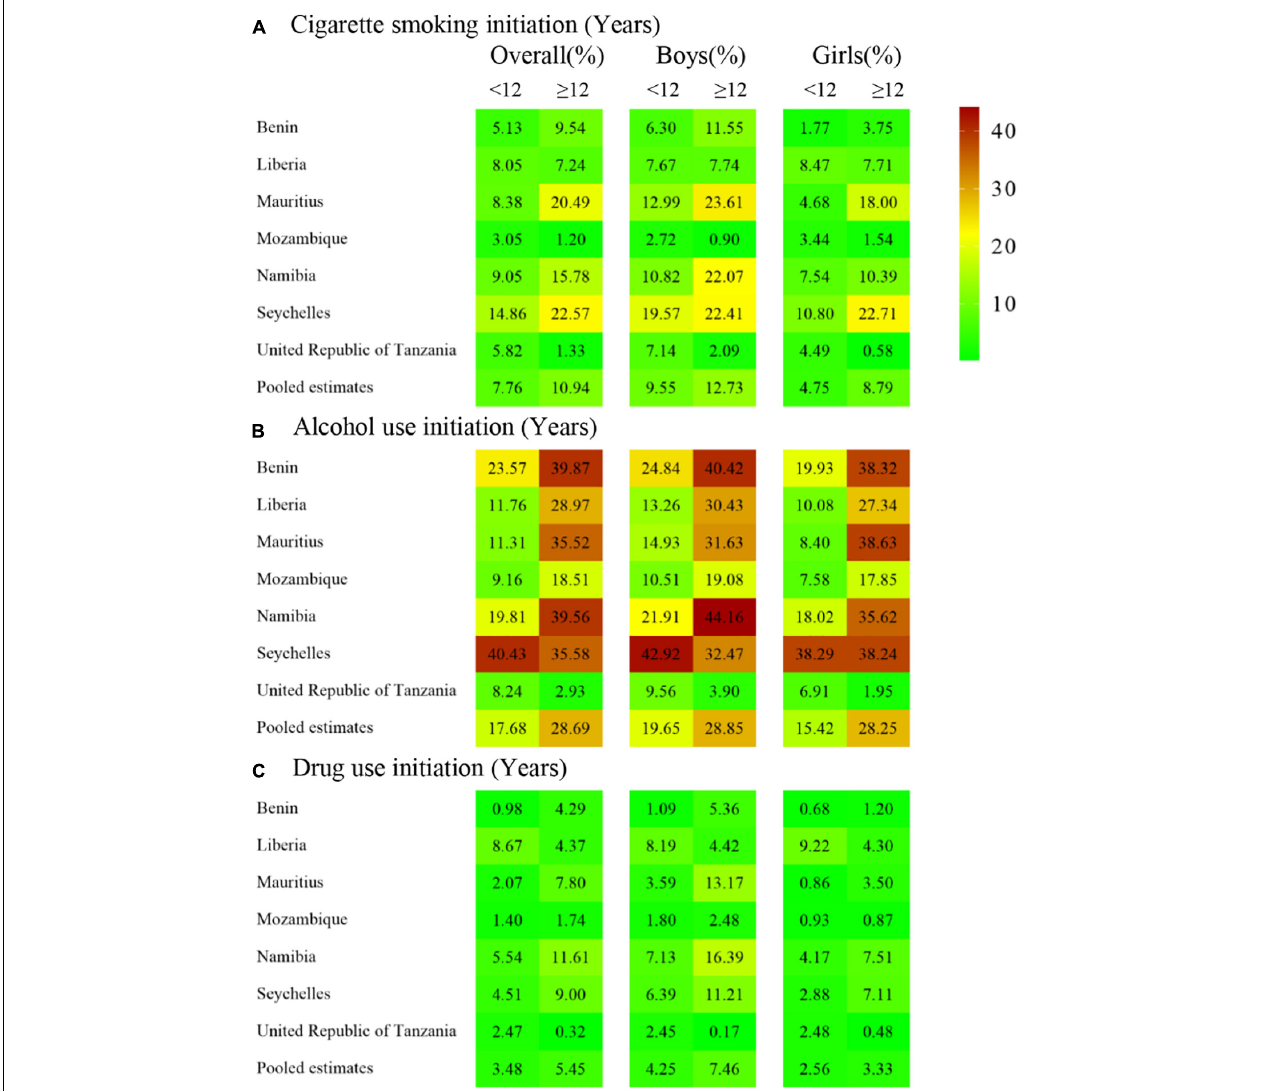
FIGURE 1 | Prevalence (%) of the early and later initiation of substance use, namely (A) cigarette smoking, (B) alcohol use, and (C) drug use, by country and gender among in-school African